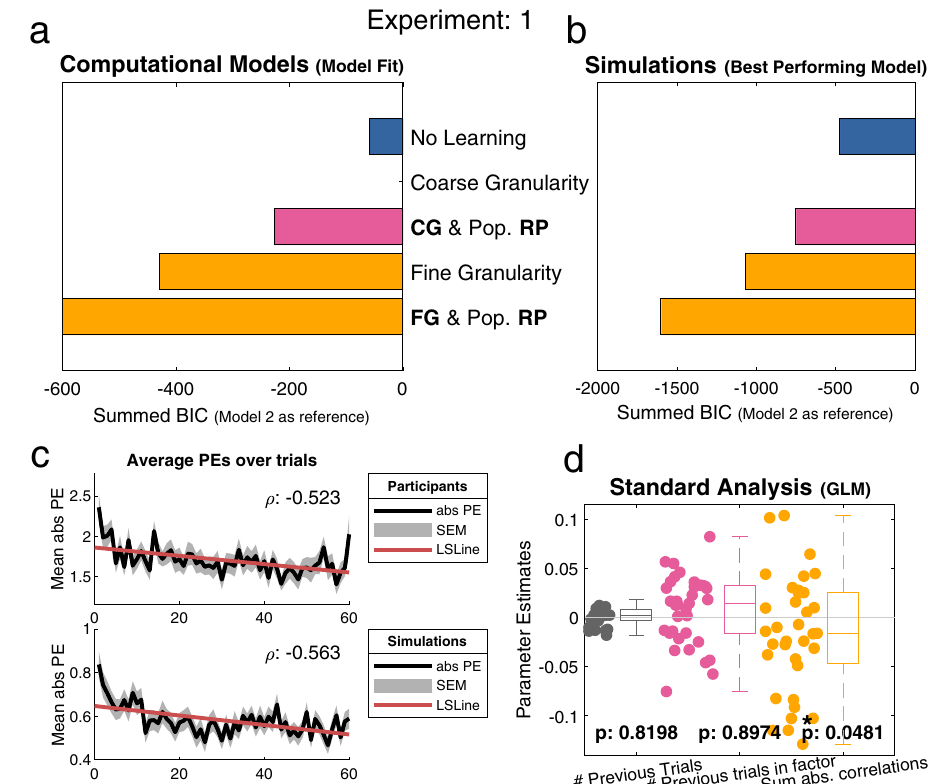
Fig. 3 | Overview of the main analyses for experiment 1. In this experiment, participants learned about the personalities offour strangers. Results indicate that participants used fi ne-grained correlation structures during learning. a Model comparisonresultsusing fi xed-effectsanalysis(losingmodelasreference)indicate Model5[FineGranularity(FG)&PopulationReferencePoint(RP)]asthebest fi